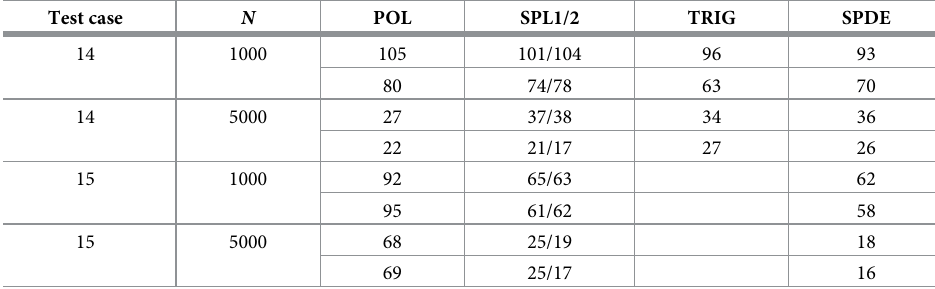
Table 8. Effect of boundary terms on model accuracy: Mean integrated squared error (scaled by 10 4 ) estimated as an average over 100 realisations. The upper row refers to models without boundary terms, the lower row to models allowing for logarithmic boundary terms at any boundary point.